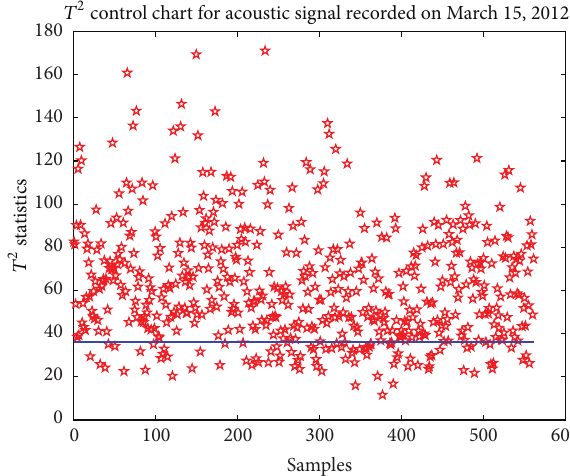
Figure 7: 𝑇 2 control chart for acoustic signal recorded eight weeks after grinding table